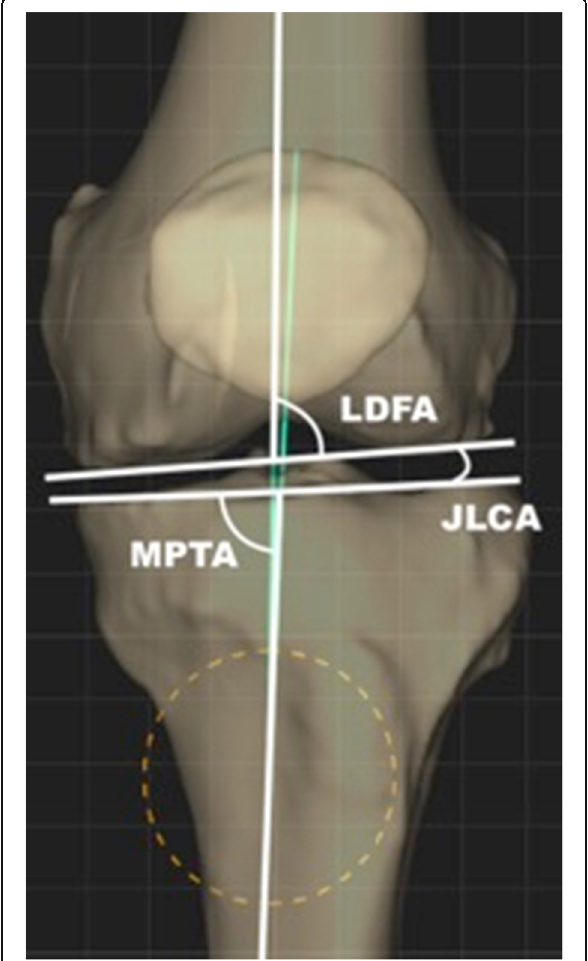
Fig. 1 Illustrations of the anatomical measurements. The lateral distal femoral angle (LDFA) was defined as the lateral angle between the femoral axis and the tangent to the femoral condyles. The medial proximal tibial angle (MPTA) was defined as the medial angle between the tibial anatomic axis and the joint line of the proximal tibia. The joint line convergence angle (JLCA) was defined as the angle between the tangent to the subchondral plates of the femoral condyle and the tibial